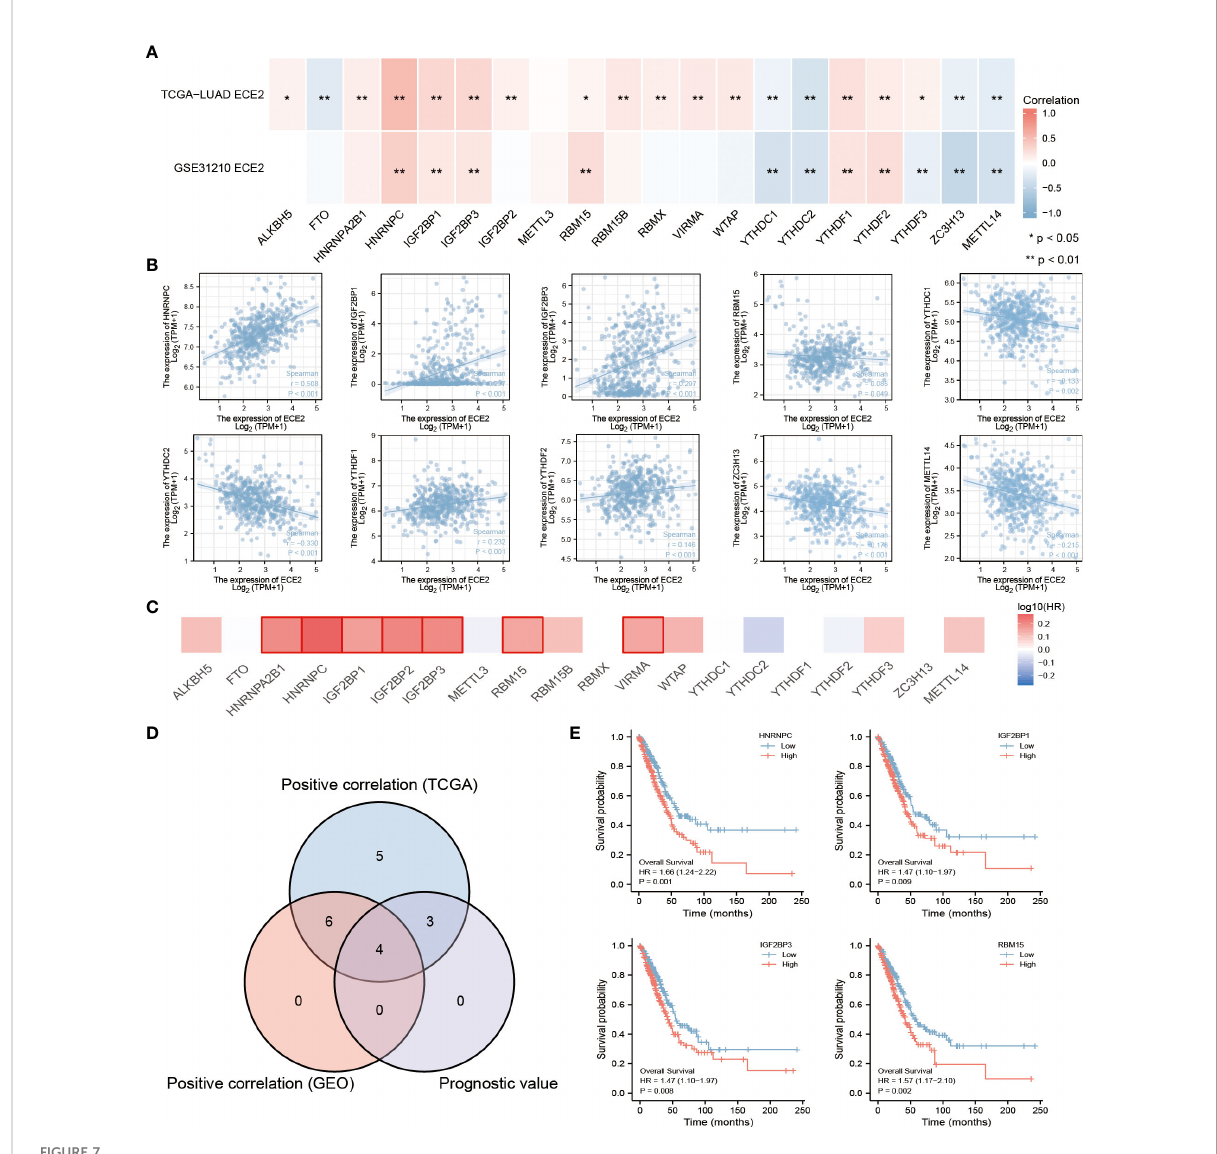
FIGURE 7 An analysis of the correlation between ECE2 expression and m6A-related genes in lung adenocarcinoma (LUAD). (A) We examined the correlation between the expression of ECE2 and m6A-related genes in LUAD using GSE31210 and the TCGA LUAD data sets. (B) To illustrate the correlation between ECE2 and m6A gene expression, scatterplots were drawn. (C) Survival maps for the m6A-related gene. (D) Venn diagrams show their overlapping genes. (E) Kaplan-Meier curve of HNRNPC, IGH2BP1, IGH2BP3 and RBM15. (Wilcoxon rank sum test) *P < 0.05; **P <